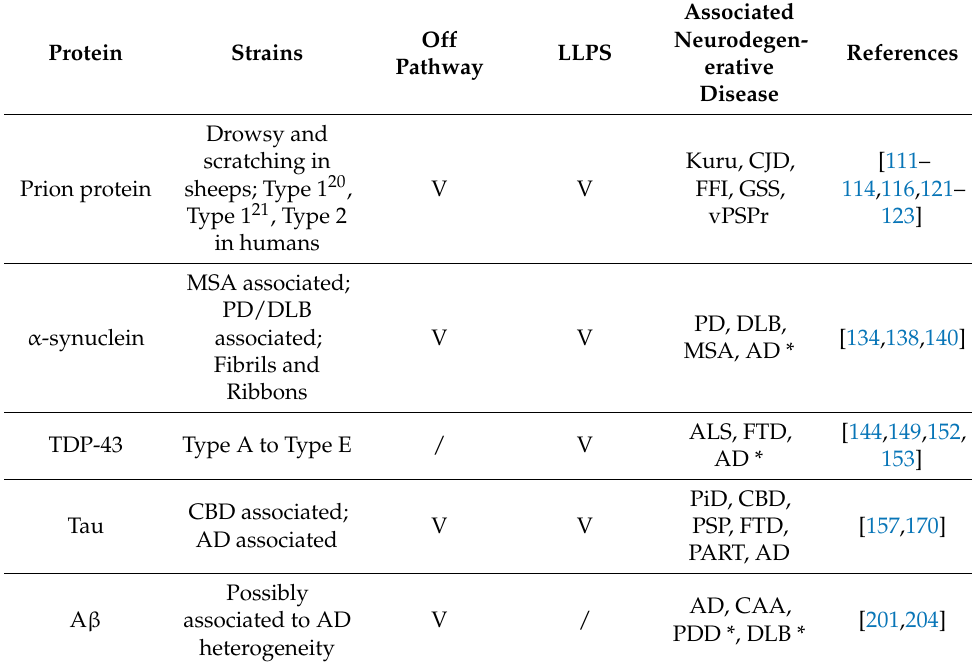
Table 2. Higher order structures and